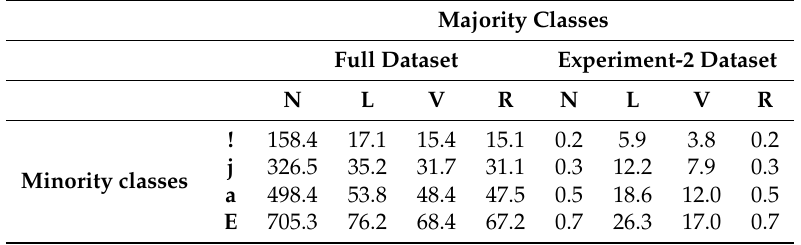
Table 8. redIR values comparison between full dataset and dataset of the best solution on experiment